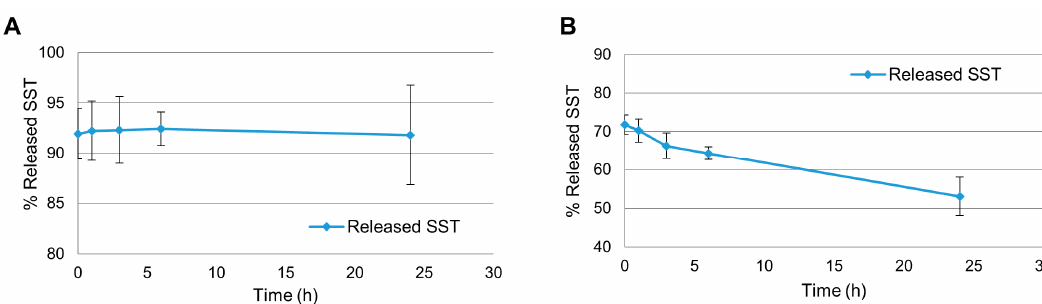
Figure 3. Released somatostatin (SST) from the nanoemulsions (NEs) following protocol 1 in 0.1 M buffer citrate pH 5.0. ( A ) % released SST considering the sum of the SST fraction found in aqueous phase (direct analysis) and the SST fraction in the lipid droplets (indirect analysis) at each time point. ( B ) % released SST in the aqueous phase considering as 100% the initial amount of SST used in the preparation procedure (0.5 mg/mL).